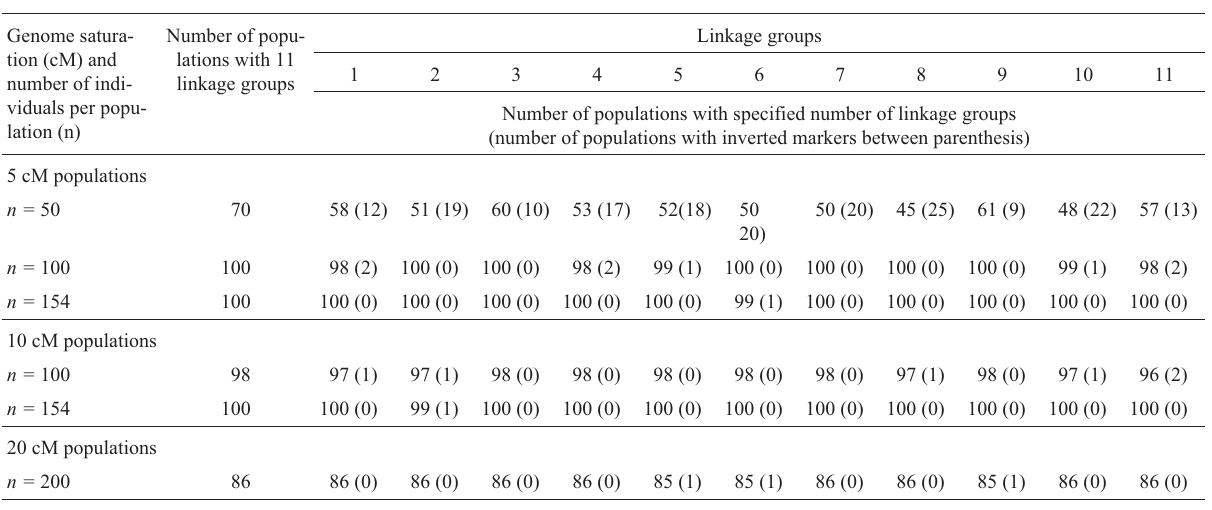
Table 2 - Linkage groups with inverted markers. The table shows the genome marker saturation level (in cM) and the number of individuals (n) in each population size in respect to the number of populations with 11 linkage groups out of a total of 100 populations for each genome marker saturation level population size ( n = 50, n = 100, etc). The number of populations ( n = 50, n = 100, etc) with inverted markers (between parenthesis) was only evaluated in the populations that led the formation of 11 linkage groups.